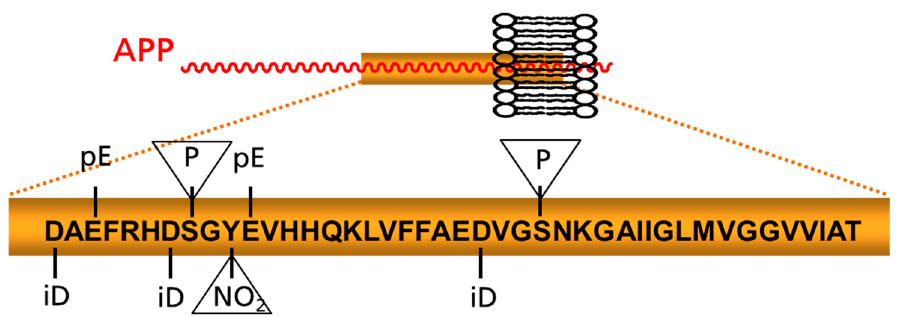
Figure 1. Schematic depiction of prominent posttranslational modifications of A β . Modifications appearing within the peptide chain and those addressing amino acid side chains (in triangles) are highlighted. APP: amyloid precursor protein; iD: isoaspartate; NO 2 : nitration pE: pyroglutamate; P: phosphorylation site.